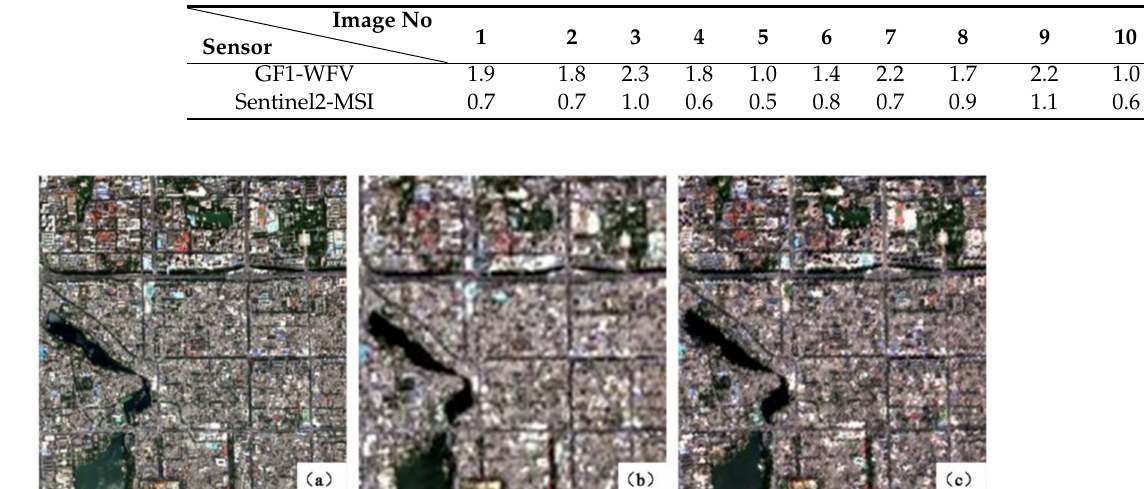
Table 2. The geolocation offset in pixel compared to Landsat-TM.